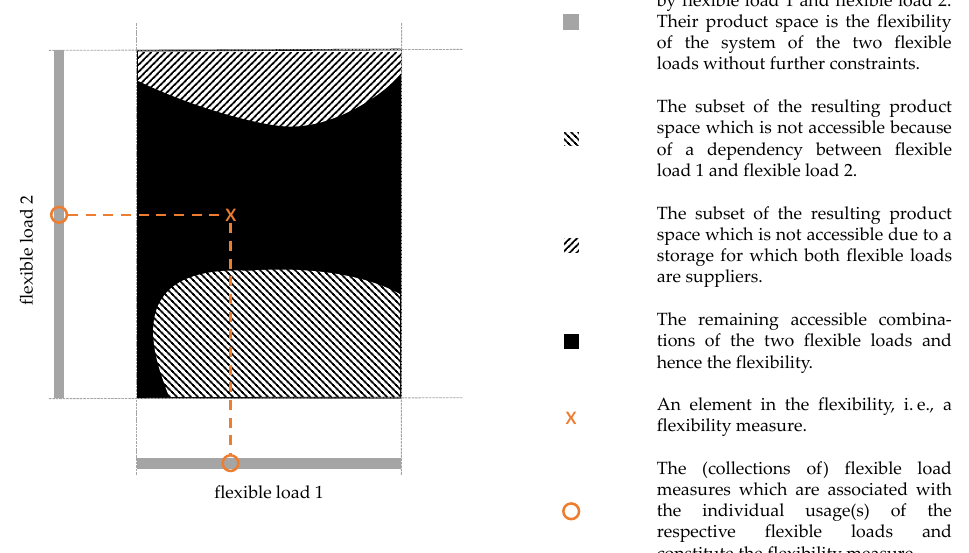
Figure 2. Our definition of a flexibility, visualized in a setting with two flexible loads with each exhibiting one degree of